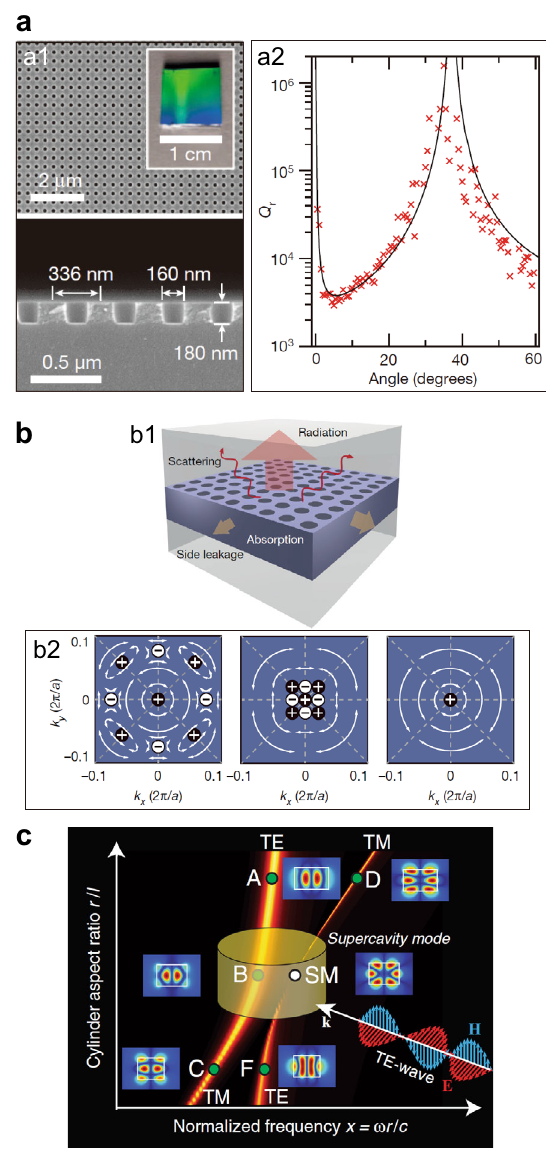
Fig. 3 Various types of BICs. a Symmetry-protected and accidental BICs. Scanning electron microscope (SEM) images of the fabricated BIC structure in top and side views (a1). Normalized radiative lifetime Q r extracted from the measured re fl ectivity spectrum as a function of the angle (a2). Reprinted by permission from ref. 16 , copyright 2013. b Merging-BIC. Schematic of a photonic crystal slab hosting BICs (b1). Far- fi eld polarization plots in the evolution of merging process, from the isolated BIC (left) to merging-BIC (right) (b2). Reprinted by permission from ref. 20 , copyright 2019. c Formation of quasi-BIC by strong mode coupling in a high-index dielectric resonator. Reprinted by permission from ref. 35 , copyright